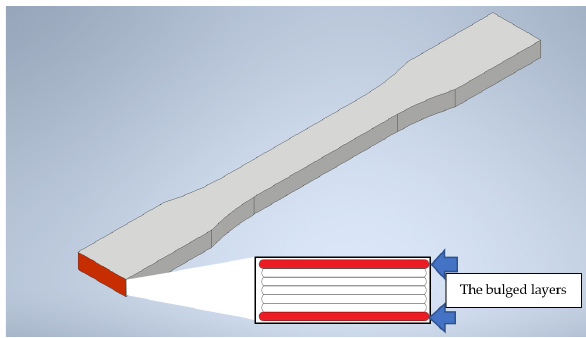
Figure 5. The schematic diagram of the bulged layers. Table 5. The hardness (Shore D) measurement results on the edge surface.